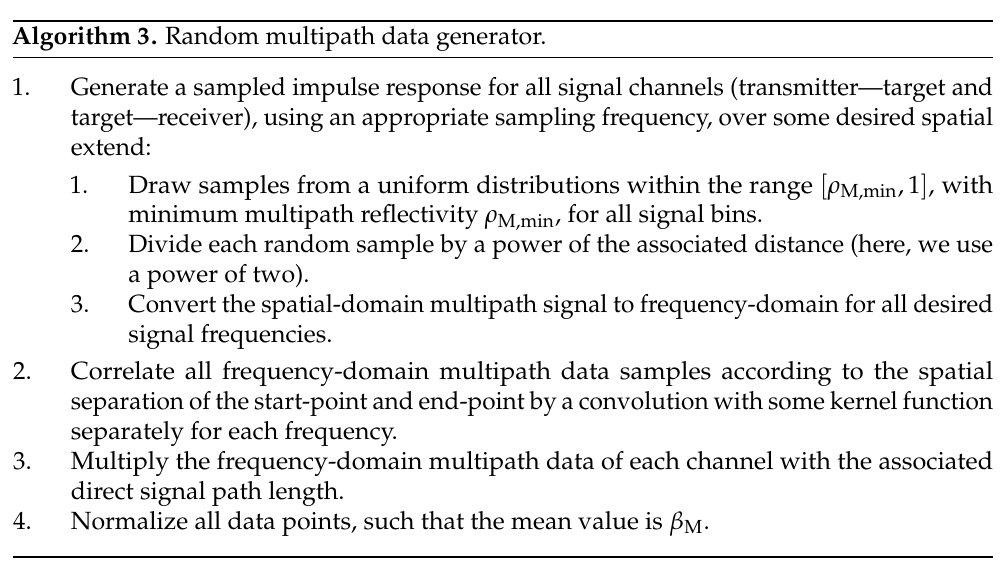
Algorithm 3. Random multipath data